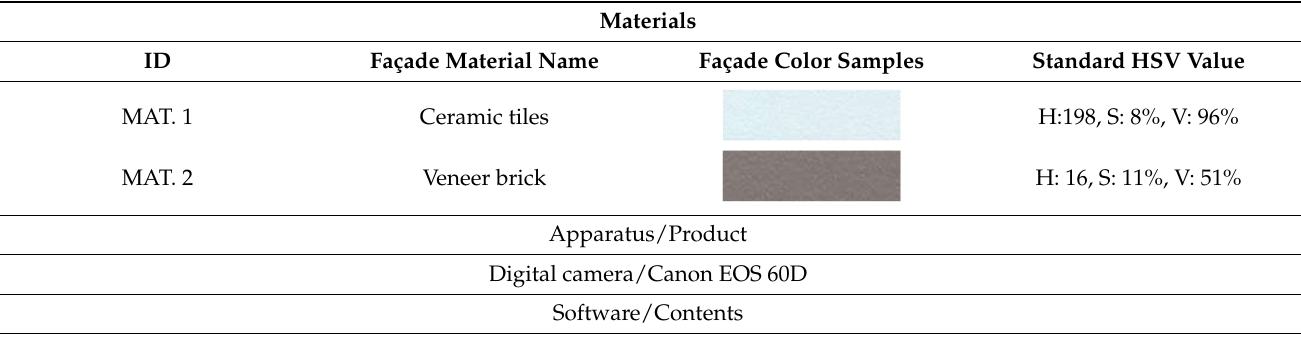
Table 4. Materials, apparatus, and software.